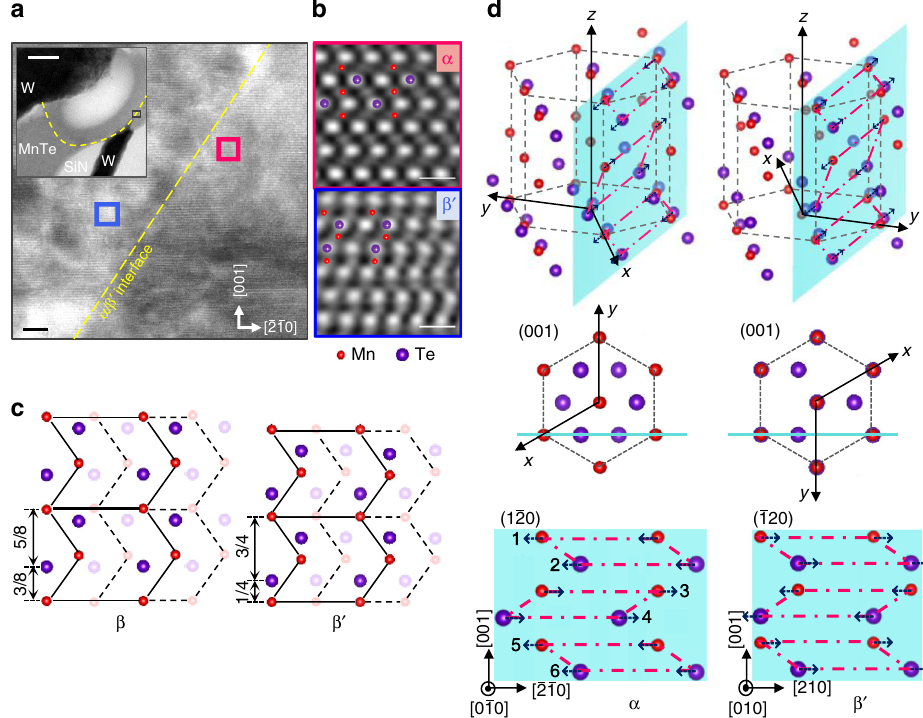
Fig. 3 Polymorphic-change mechanism in the MnTe device. a High-resolution transmission electron microscopy (HR-TEM) image in the 0 (cid:1) 10 ½ (cid:2) zone axis of the α -matrix from the area enclosed by the black line in the upper left inset. Scale bar: 5 nm. The upper left inset corresponds to the scanning transmission electron microscopy (STEM) image of Fig. 2b, where the TEM sample was additionally ion milled. Scale bar: 100 nm. b Inverse fast Fourier transform (IFFT) images of annular dark- fi eld STEM (ADF-STEM) images of the α (upper)- and β ′ (bottom)-phases from the areas enclosed by red (right side) and blue (left side) lines, respectively. Scale bar: 5 Å . c Projection of atoms in the β (left)- and β ′ (right)-phases viewed from the [010] direction, solid atoms are in the (cid:1) 120 ð Þ plane, and semi-transparent atoms in the neighboring plane. d Polymorphic-change mechanism between the α - and β ′ -phases through alternate atomic-plane shuf fl ing. Upper images show a crystal structure of the α (left)- and β ′ (right)-phases. Middle images show a projection of atoms in the α (left)- and β ′ (right)-phases viewed from the [001] direction. Bottom images present a projection of atoms on the light-blue colored plane in the α ( (cid:1) 120 ð Þ , left)- and β ′ (( (cid:1) 120 ð Þ ), right)-phase structure. The dotted arrows indicate the shuf fl ing direction of each atomic-plane for the polymorphic-change from the α - to β ′ -phase (left) and from the β ′ - to α -phase (right).